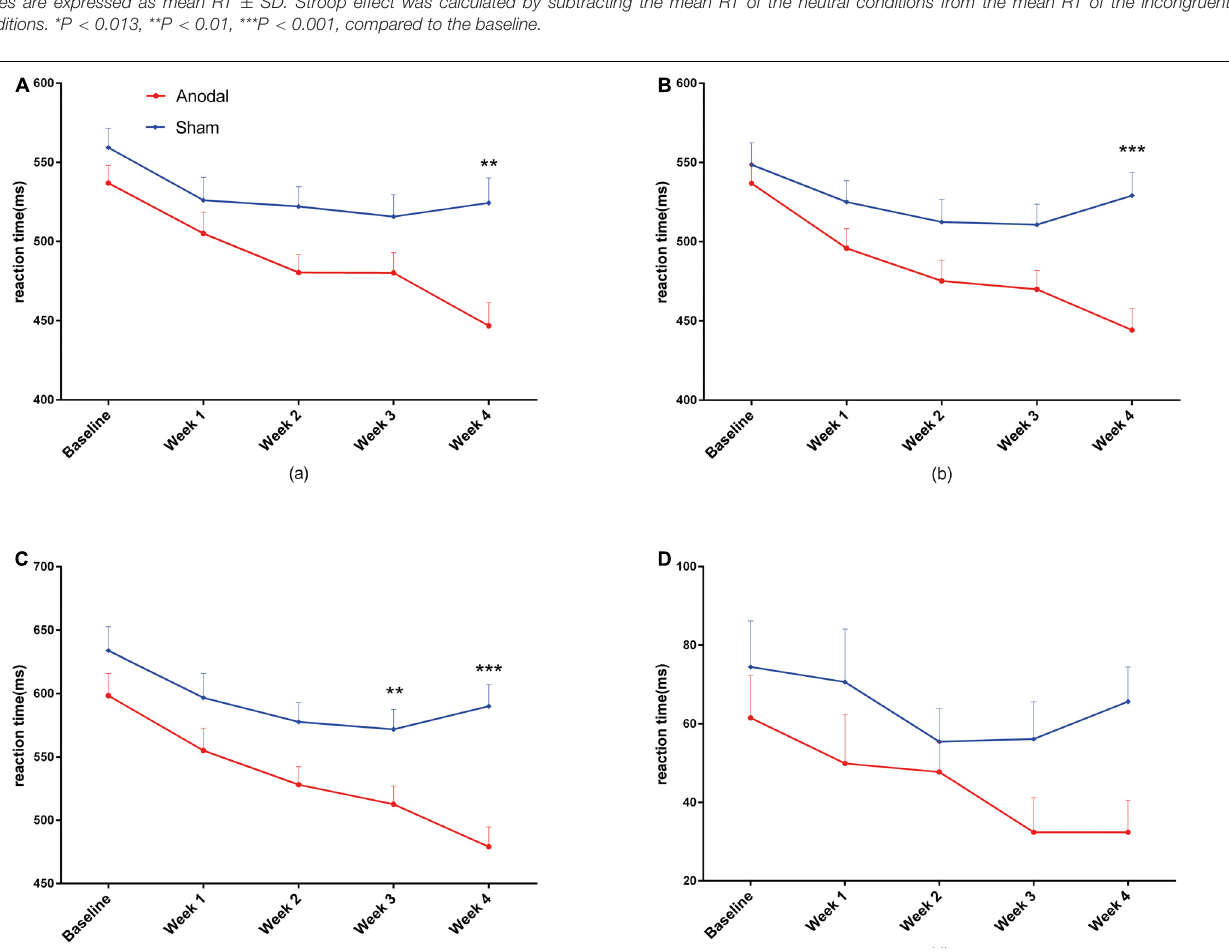
additionally, studies have shown that stimulation of the